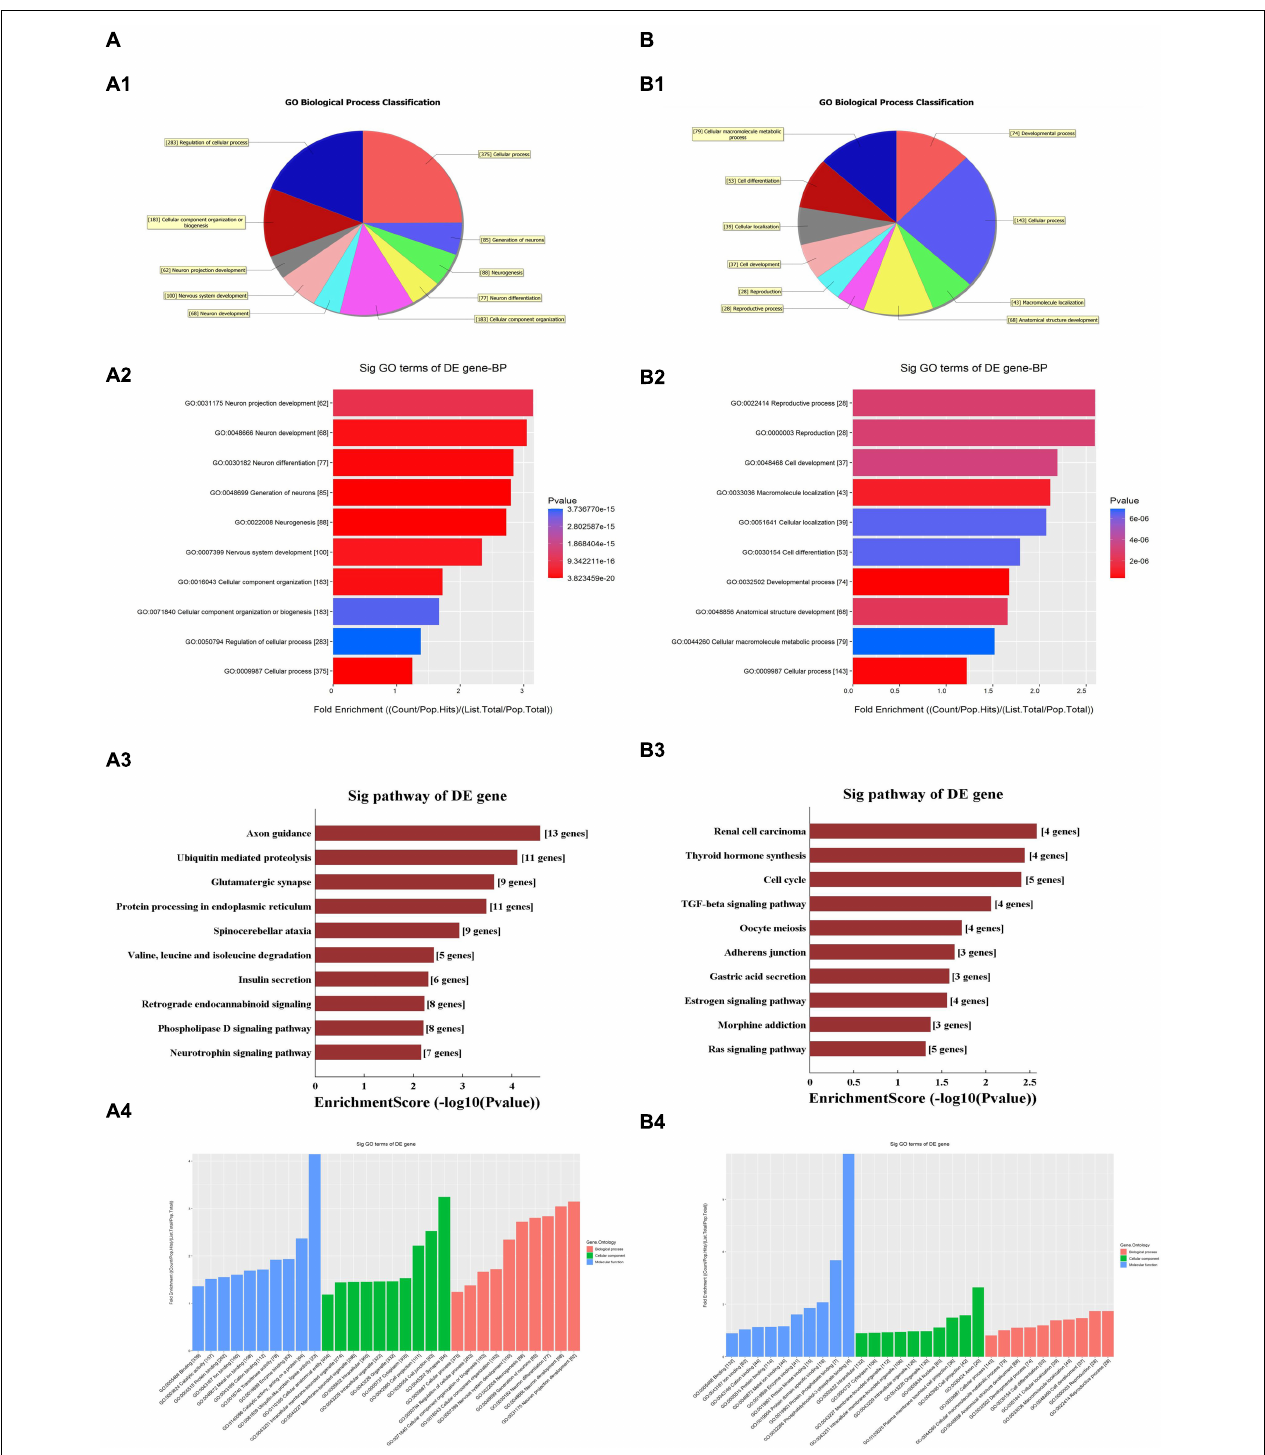
FIGURE 3 | Gene Ontology (GO) and Kyoto Encyclopedia of Genes and Genomes (KEGG) analyses for upregulated and downregulated (A,B) circRNAs. (A1,B1) Classification of the GO analysis predicted biological processes. (A2,B2) Top 10 significantly enriched genes based on their fold enrichment scores. (A3,B3) KEGG pathway analysis showing the top 10 significantly enriched pathways and their scores. (A4,B4) GO analysis predictions in cellular component and molecular function. GO gene ontology; Sig, significantly; BP, biological processes. Selection counts, count of the genes’ entities directly associated with the listed pathway ID; Selection Size, the total number of the genes’